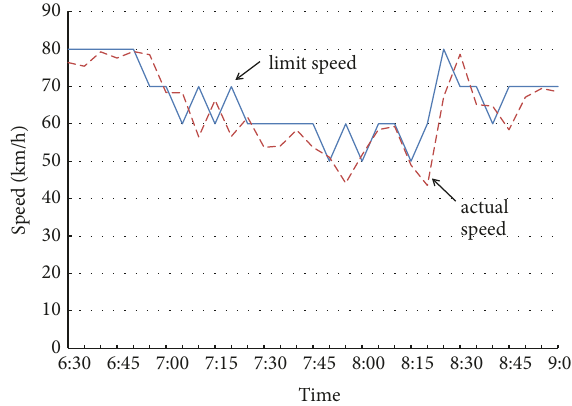
Figure 10: Comparison between limit speed and actual speed under modified METANET